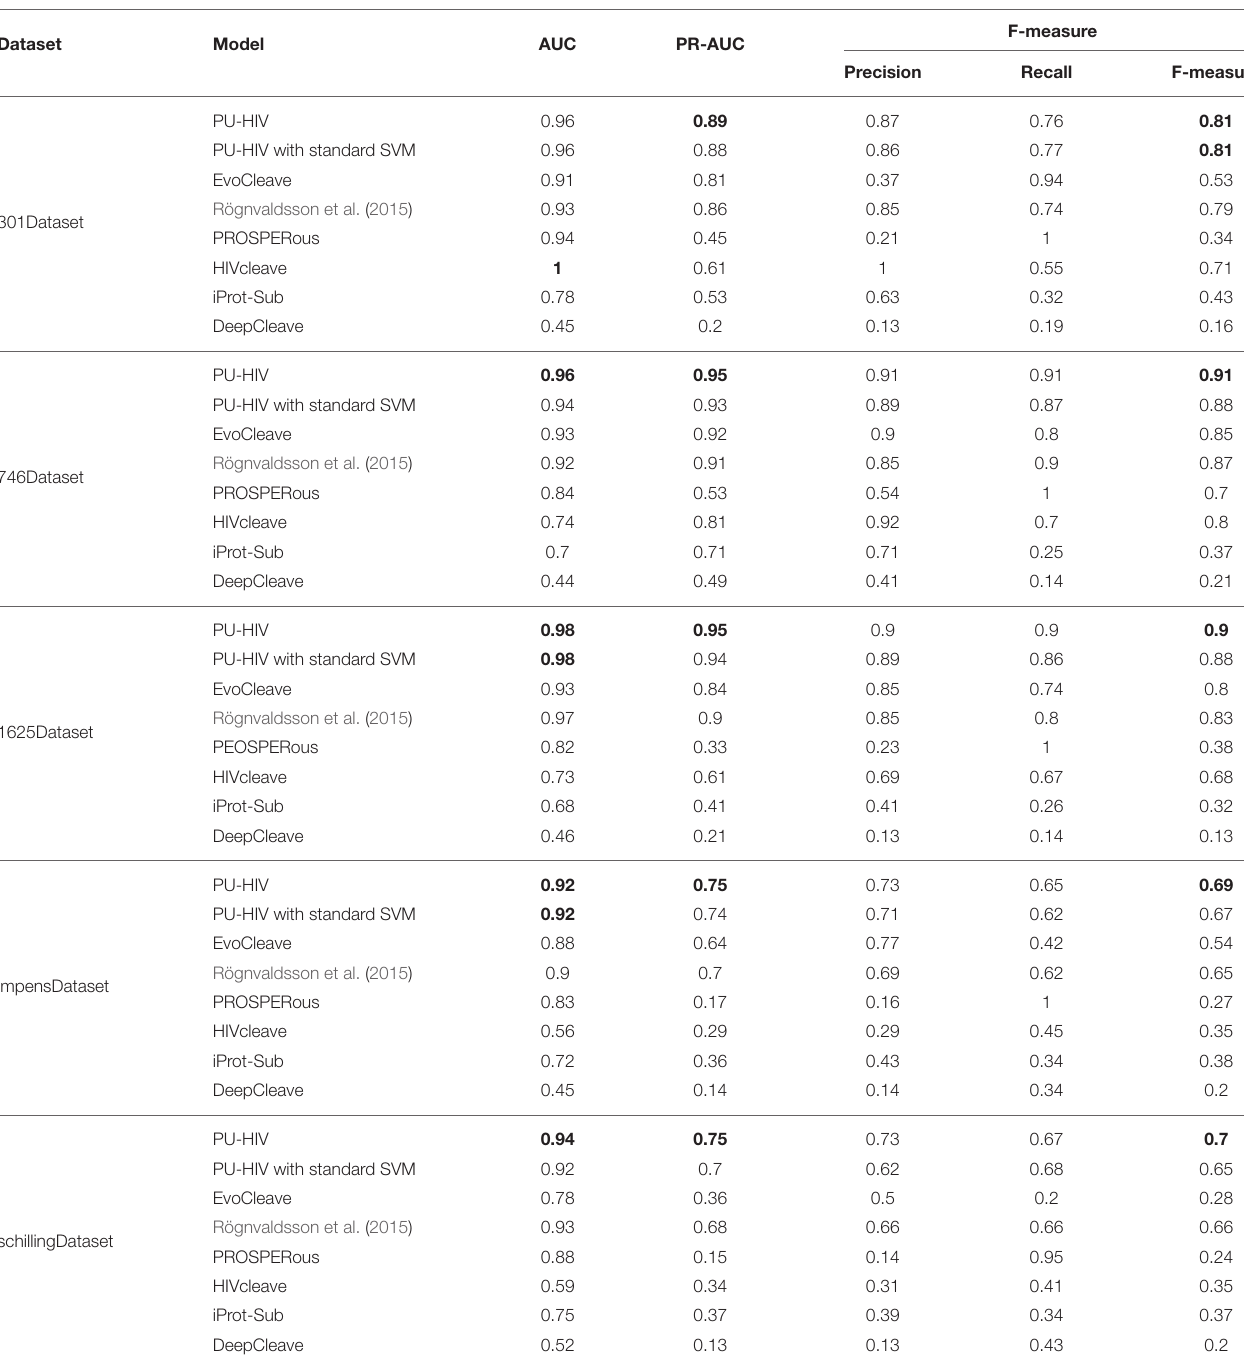
TABLE 3 | Experiment results of 10-fold CV.